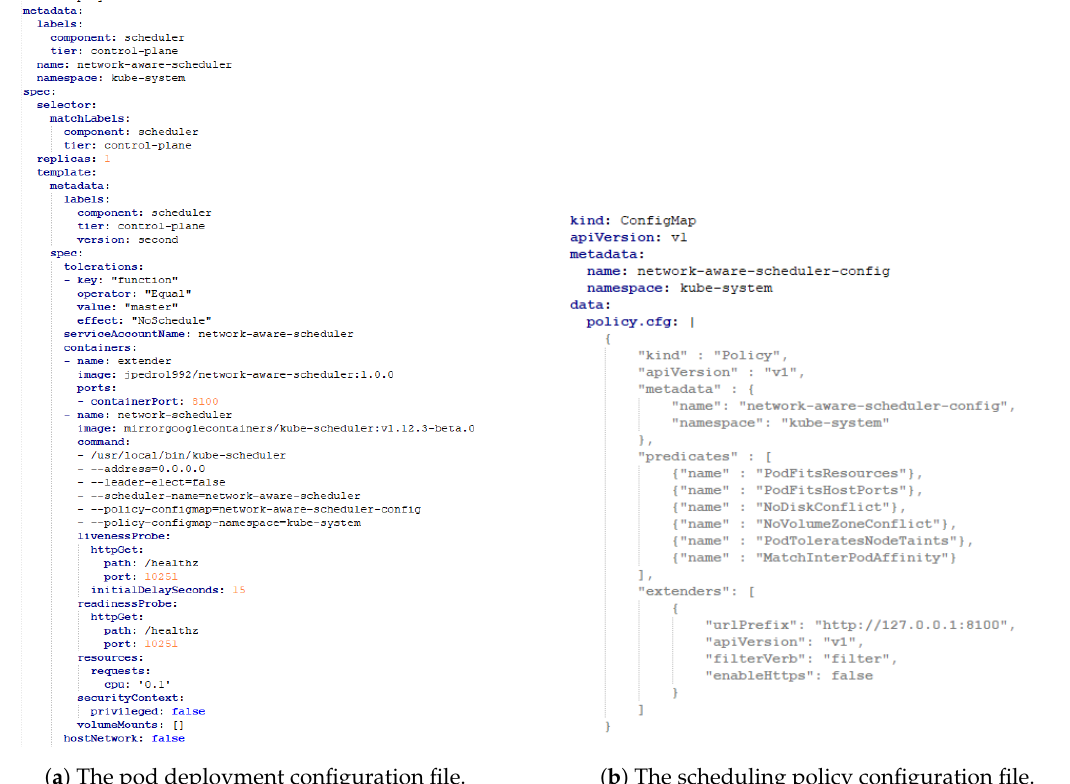
Figure 6. The configuration files required for the